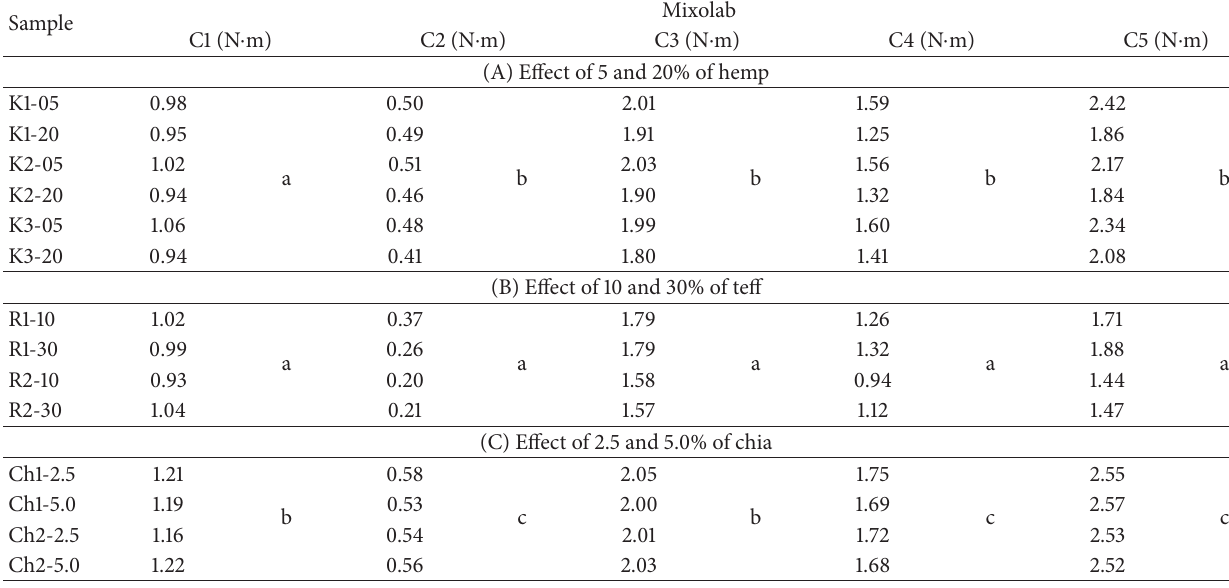
Table 2: Mixolab test results of wheat flour composites.